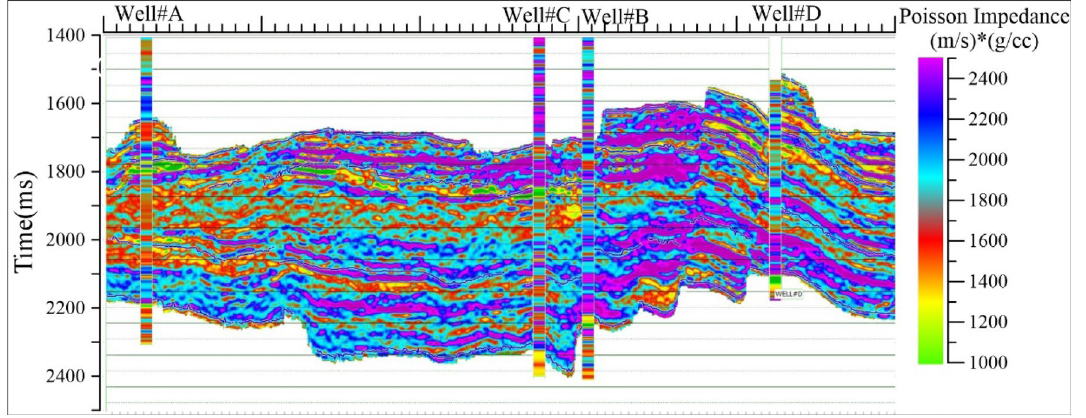
Figure 5. Arbitrary line of Poisson Impedance (PI) volume intersects at wellbore locations with PI